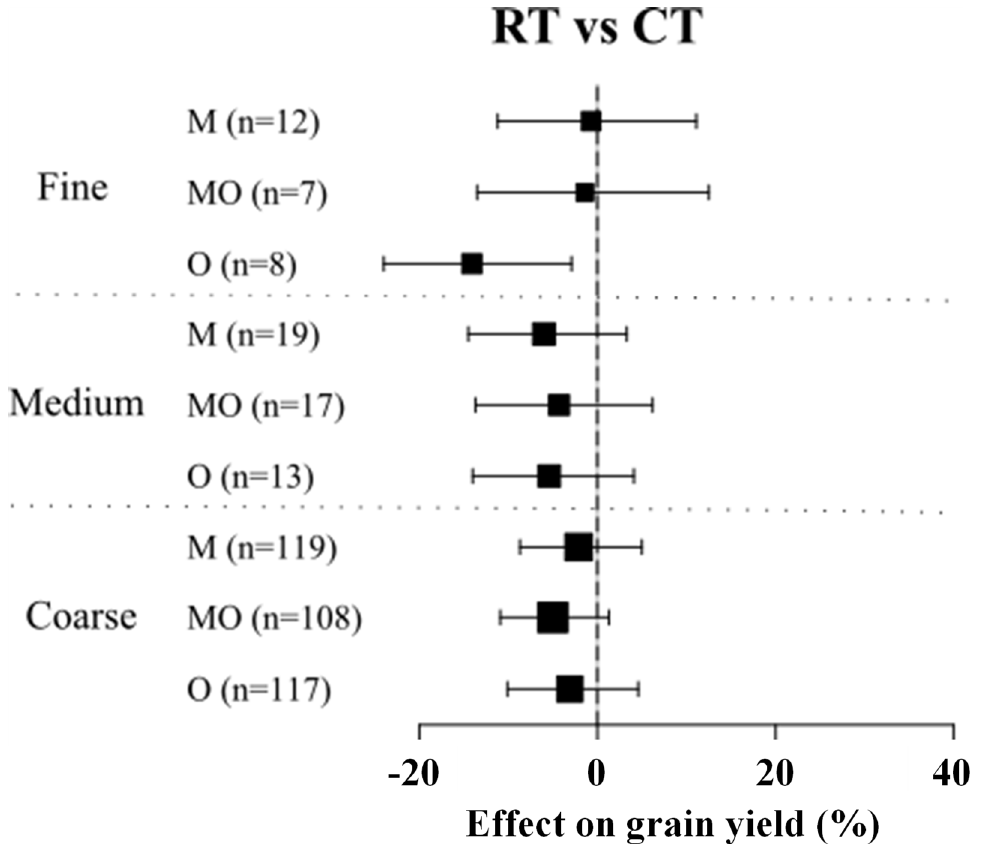
Figure 3. The response of reduced tillage vs. the conventional tillage practices (RT vs. CT), under different nutrient sources; inorganic (M), organic (O), and inorganic + organic (MO), under different soil properties, expressed as the average effect on grain yield (%). “n” refers to the number of observations for each subgroup. The vertical line represents the null hypothesis [ln (RR) = 0]. The squares are the point estimate of effect size. The horizontal lines are the associated 95% confidence interval for the population parameter.